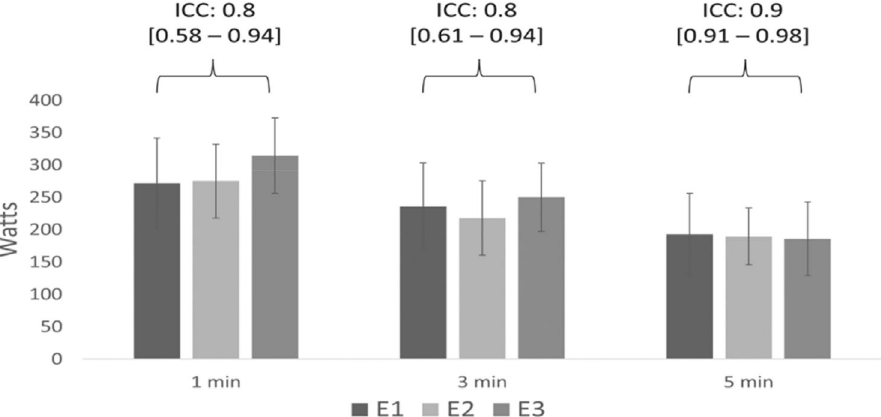
Figure 3 - Intraclass correlations among evaluators for each stage length. E1 = Evaluator 1, E2 = Evaluator 2, E3 = Evaluator 3. ICC = Intraclass Corre- lation Coefficient. P > 0.05 among